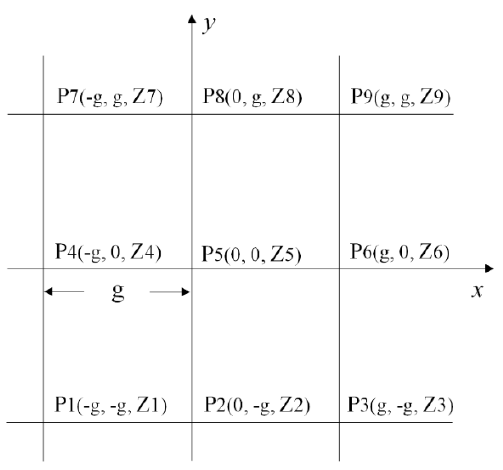
Figure 6. Distribution and numbering of the 3x3 window (g is the resolution).